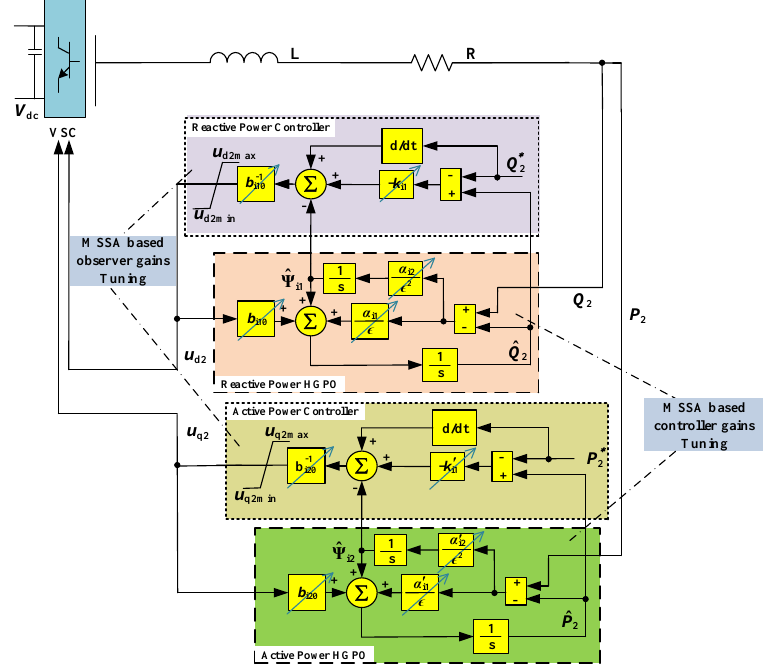
Figure 4. The overall ONAC-based control framework of inverter.